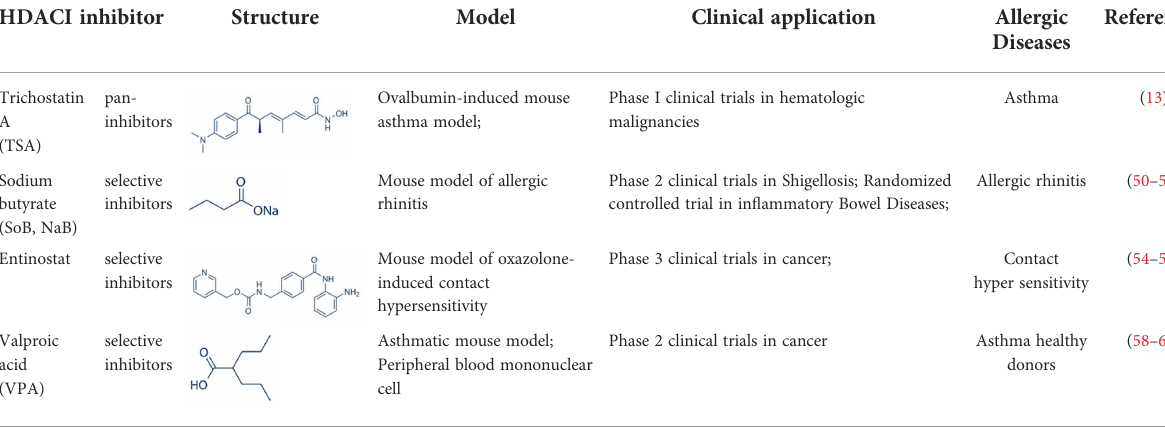
TABLE 1 The role of HDAC inhibitor in allergic